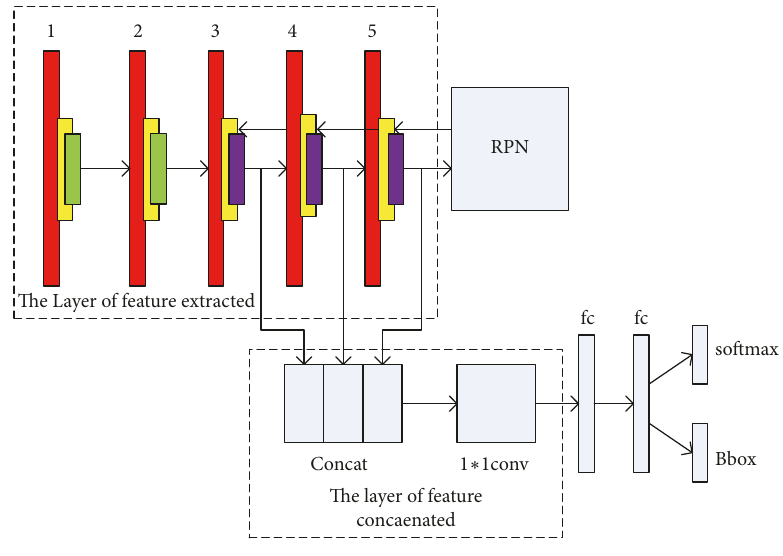
Figure 4: Our model